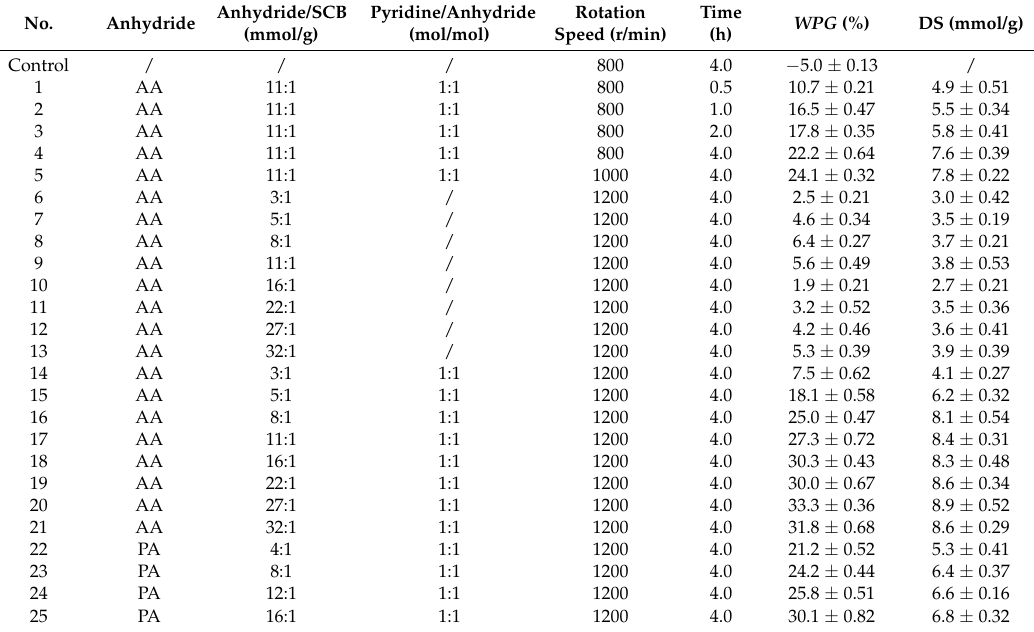
Table 1. WPG and DS values of SCB esters obtained by ball milling under various